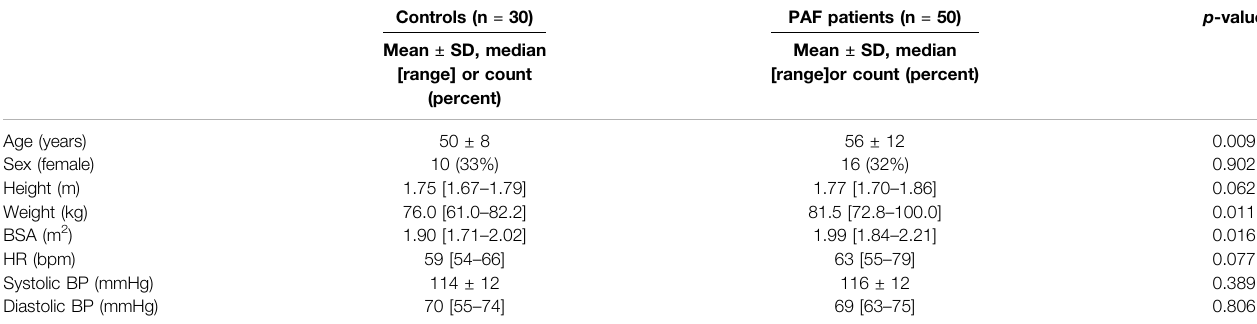
TABLE 1 | Baseline characteristics.